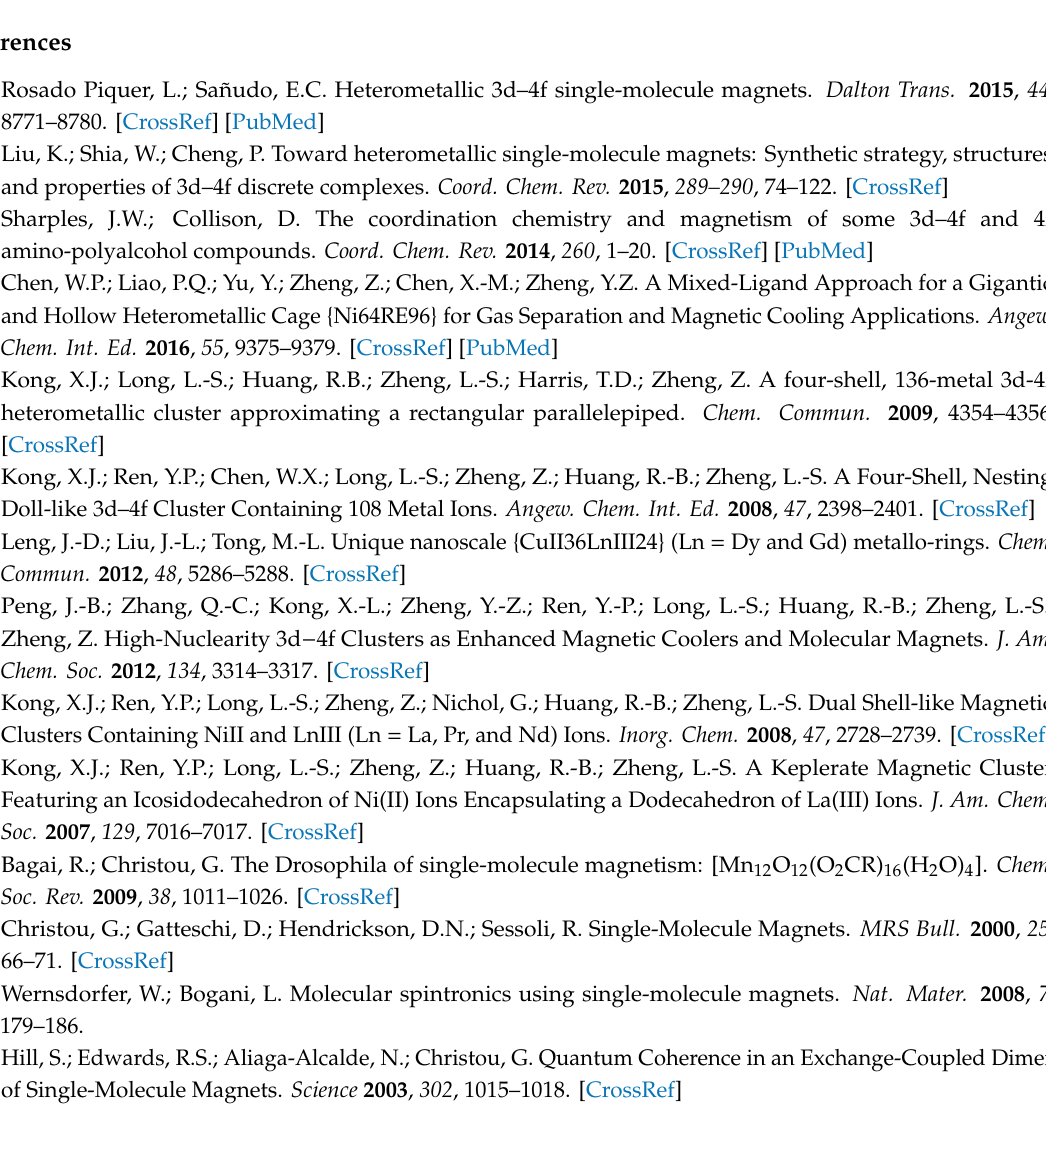
Figure S1. Representation of the elipsoid plot for 1 , Figure S2. Theoretical and experimental pxrd patterns for 1 – 4 , Figure S3: Representation of χ ’ (black line) and χ ” (red line) for 2 , Figure S4: Linear fit of the ac magnetic suscetibility data for 2 at the frequency of 1000 Hz using the generalized Debye model to extract the slow relaxation parameters, Table S1: Crystallographic data for complex 1